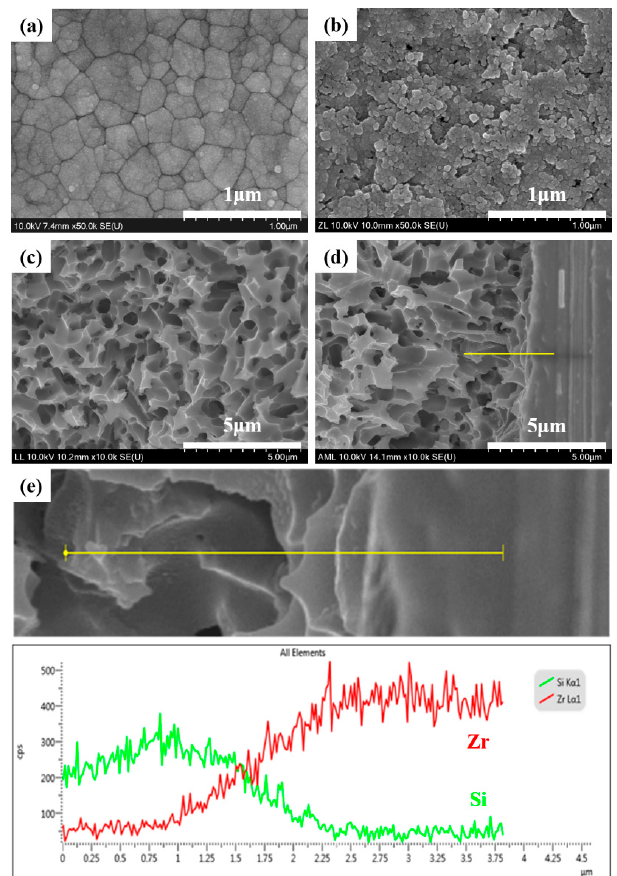
Figure 3. High-resolution field emission scanning electron microscopy (HR FE-SEM) images of the zirconia ceramic specimen demonstrating ( a ) crystal structure after sintering at 1450 °C, ( b ) its alteration of surface morphology with liner treatment (liner removed with acid etching with a 5% hydrofluoric acid solution for 30 min after a fracture test), ( c ) liner-bonded zirconia surface, and ( d ) cross-sectional view of liner-bonded interfacial interaction zone, and ( e ) energy dispersive X-ray spectrometer (EDS) line analysis data of Si and Zr after acid etching with 9.5% hydrofluoric acid gel for 30 s.